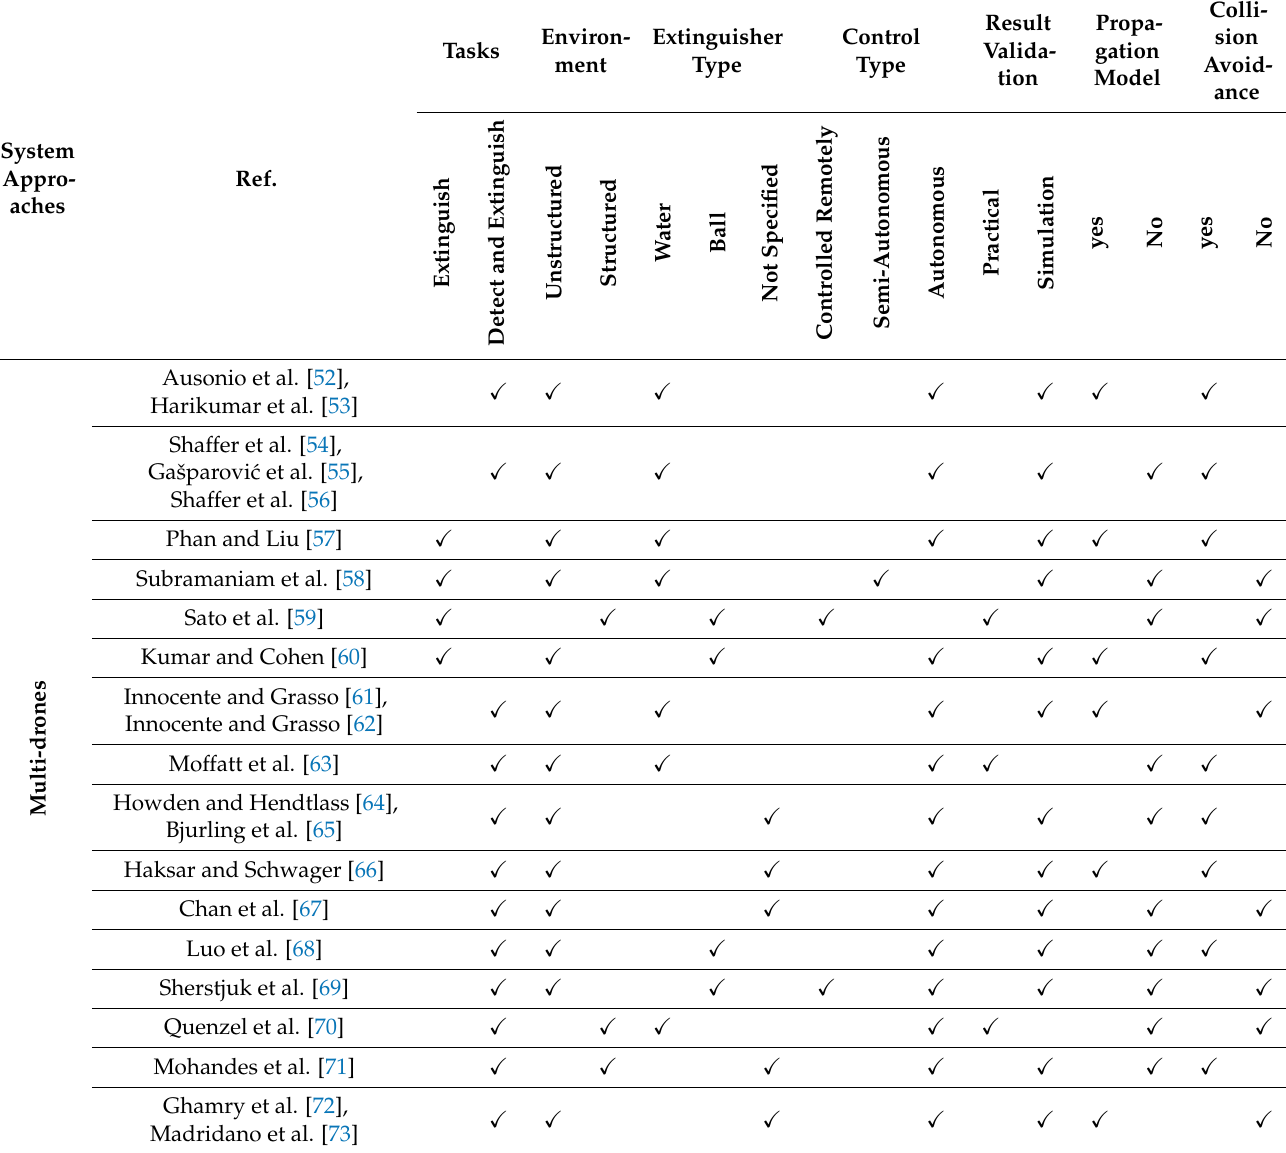
Table 9. Summary of fire-extinguishing systems using